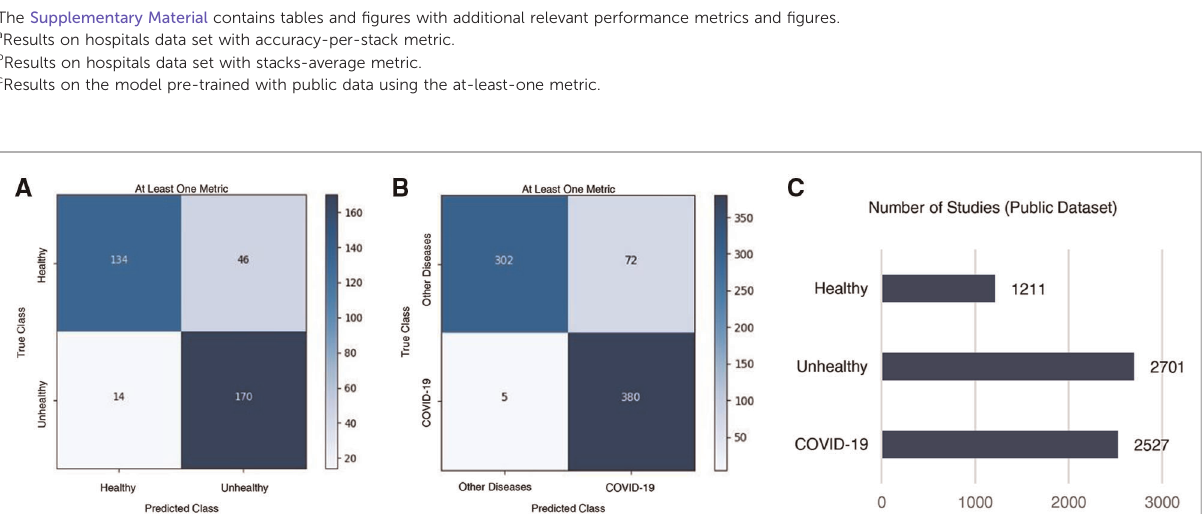
FIGURE 4 Classi fi cation results on the public test set. Confusion matrices for ( A ) healthy vs. unhealthy and ( B) other-diseases vs. COVID-19 classi fi ers. ( C ) Per- class data